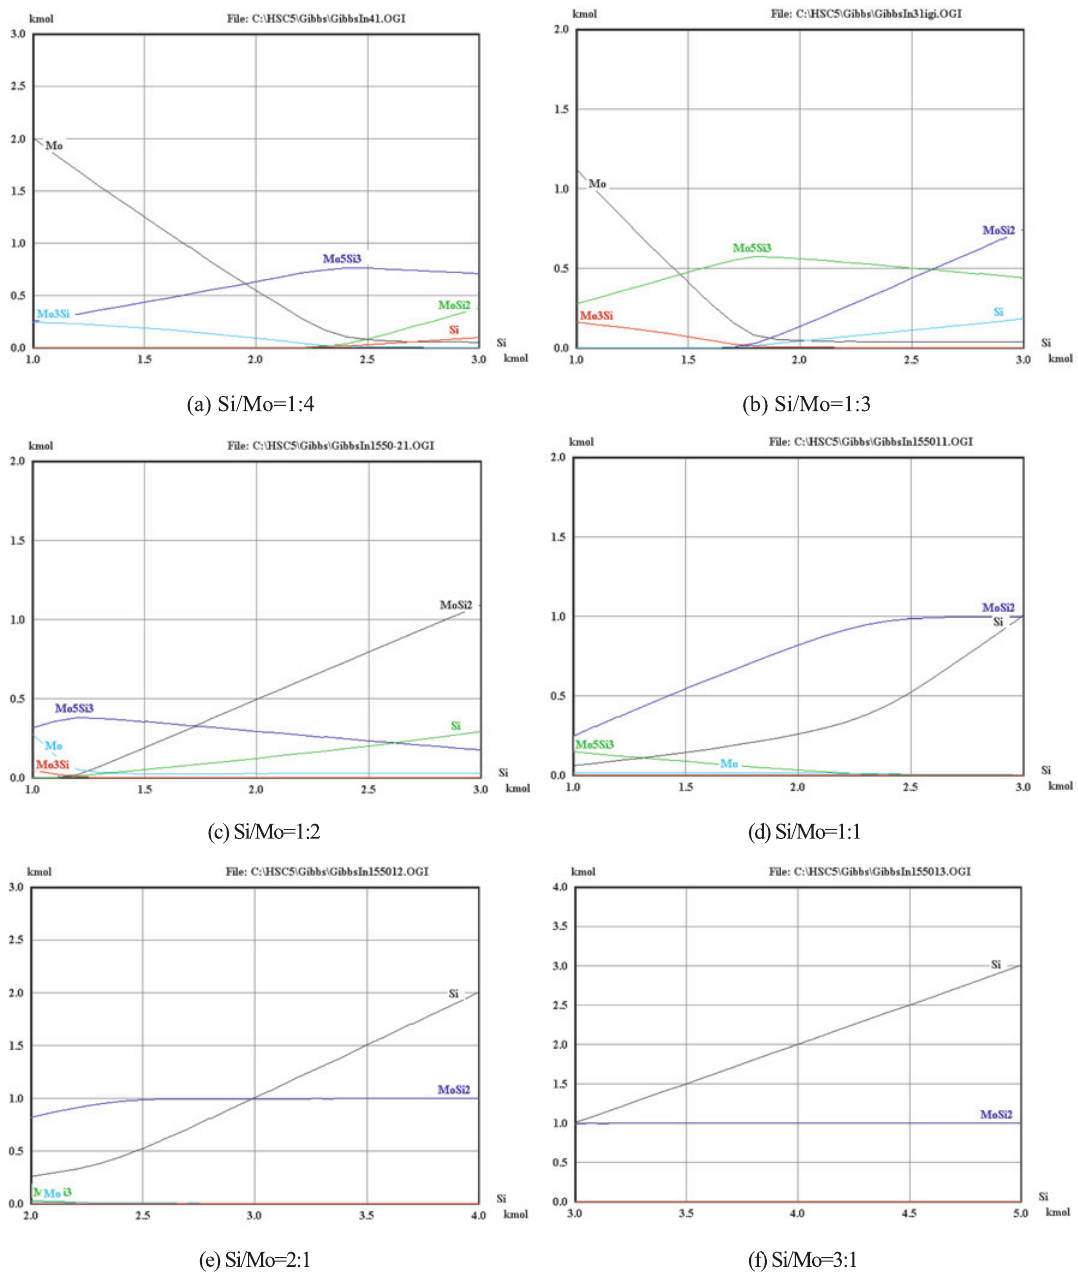
Fig. 7: Effects of Si/Mo on the equilibrium phase diagram of the Si-Mo system (temperature = 1773